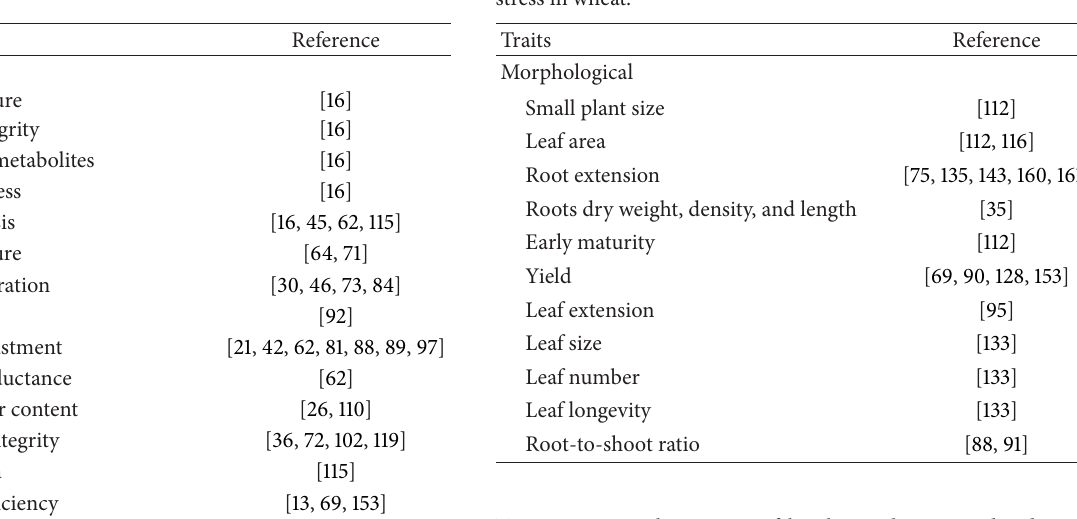
Table 6: Research scenario of biochemical traits under drought stress in